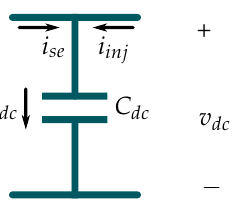
Figure 4. Current directions for node analysis in the DC